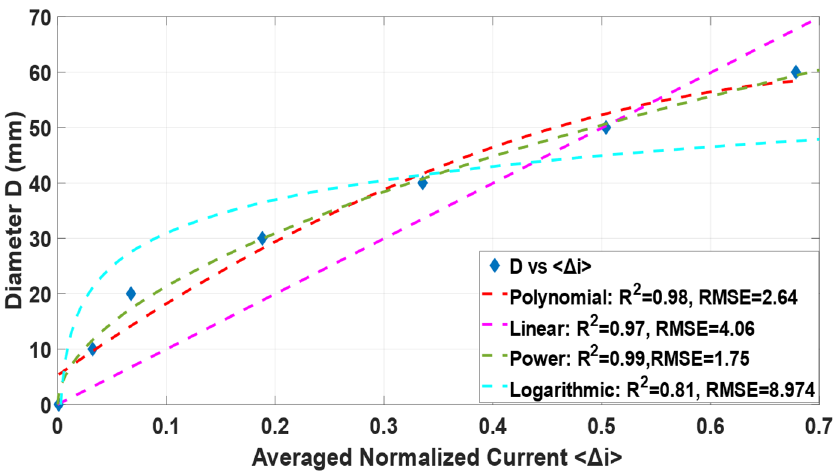
Figure 8. Comparison between (3) and the experimental dataset for the different phantoms at different locations in the pipe at 180 µS/cm.